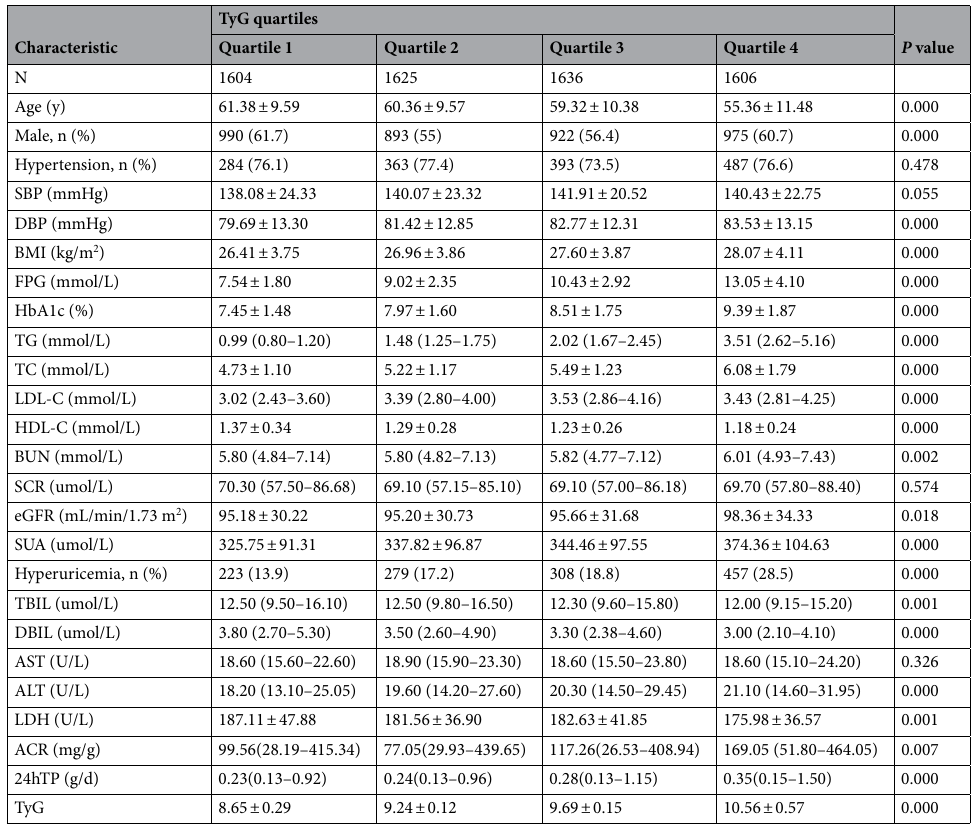
Table 1. Baseline characteristics of the subjects stratified using TyG quartiles. TyG triglyceride-glucose index; SBP systolic blood pressure; DBP diastolic blood pressure; BMI body mass index; FPG fasting plasma glucose; HbA1c glycated hemoglobin; TG plasma triglyceride level; TC total cholesterol; LDL-C low-density lipoprotein cholesterol; HDL-C high-density lipoprotein cholesterol; BUN blood urea nitrogen; SCR serum creatinine; eGFR estimated glomerular filtration rate; SUA serum uric acid; TBIL total bilirubin; DBIL direct bilirubin; AST aspartate aminotransferase; ALT alanine aminotransferase; LDH lactic dehydrogenase; ACR albumin- creatinine ratio; 24hTP 24 h total urine protein; Data are presented as the mean ± standard error or median (interquartile range) for continuous variables, and the numbers (percentage) for categorical variables. P < 0.05 was considered statistically